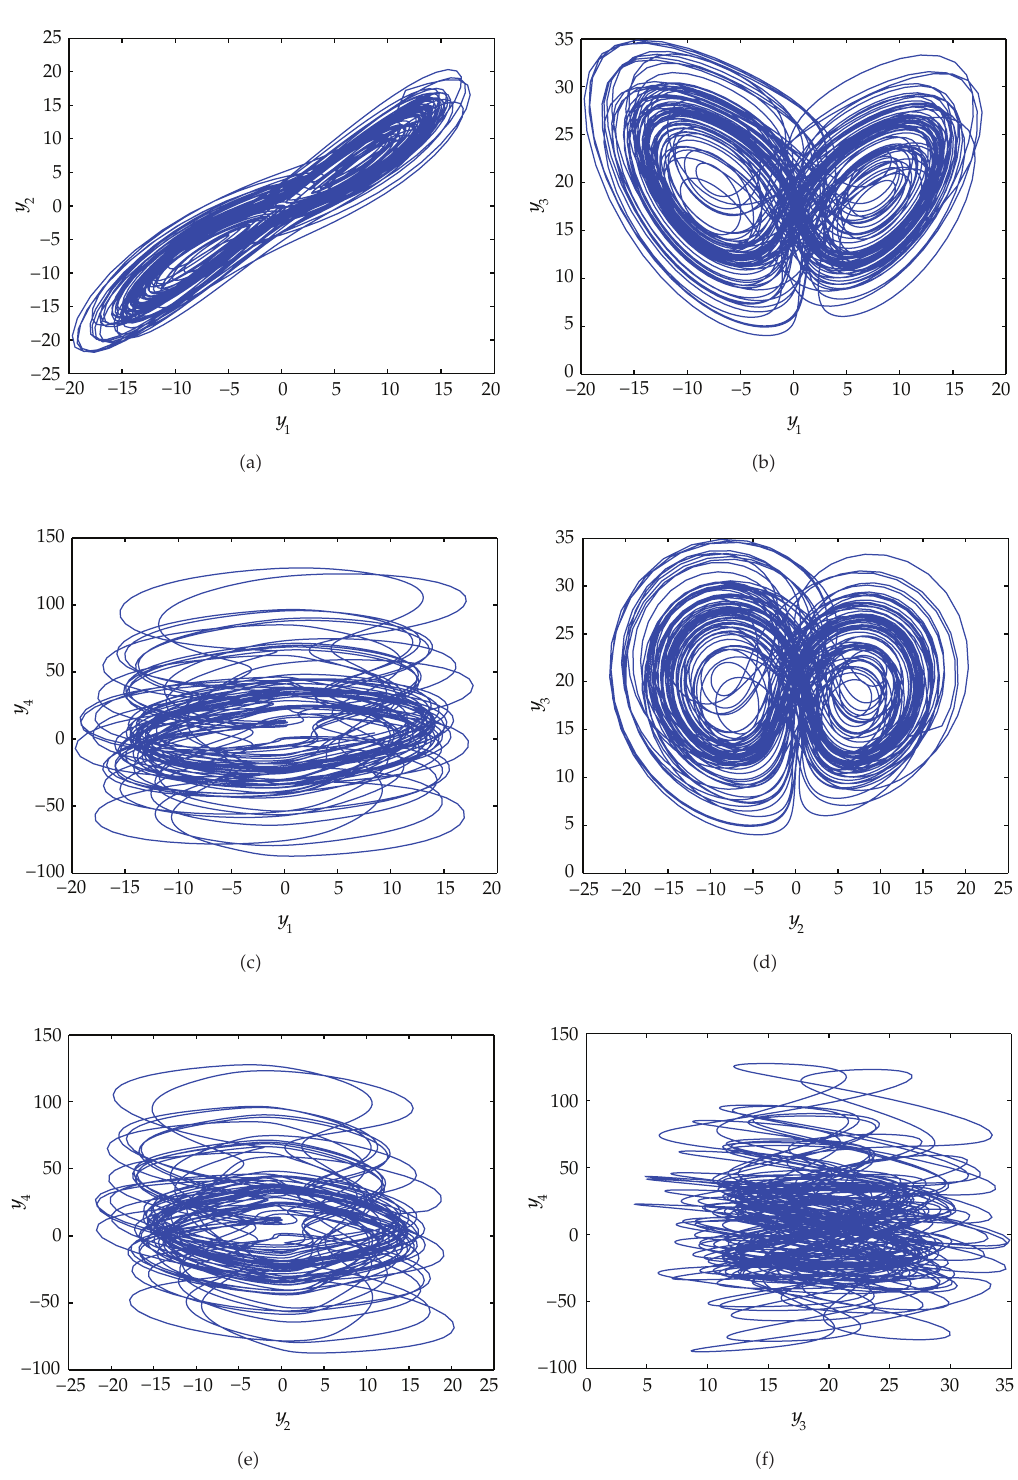
Figure 3: The projections of attractors of fractional-order hyperchaotic Chen system with order q (cid:8) 0 .